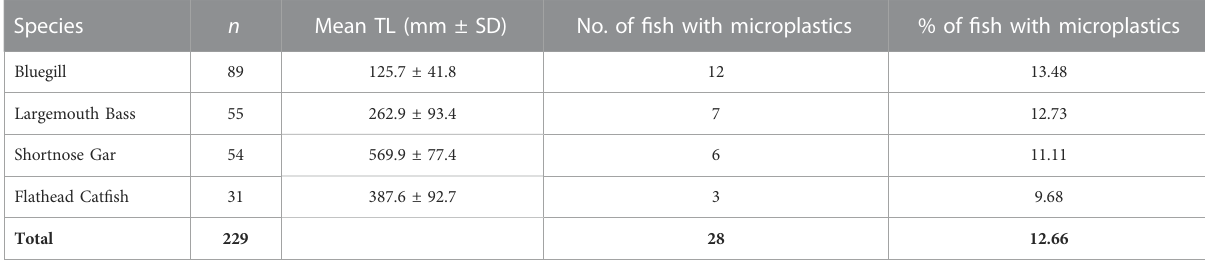
TABLE 2 Summary of fi sh samples and occurrence of microplastics.